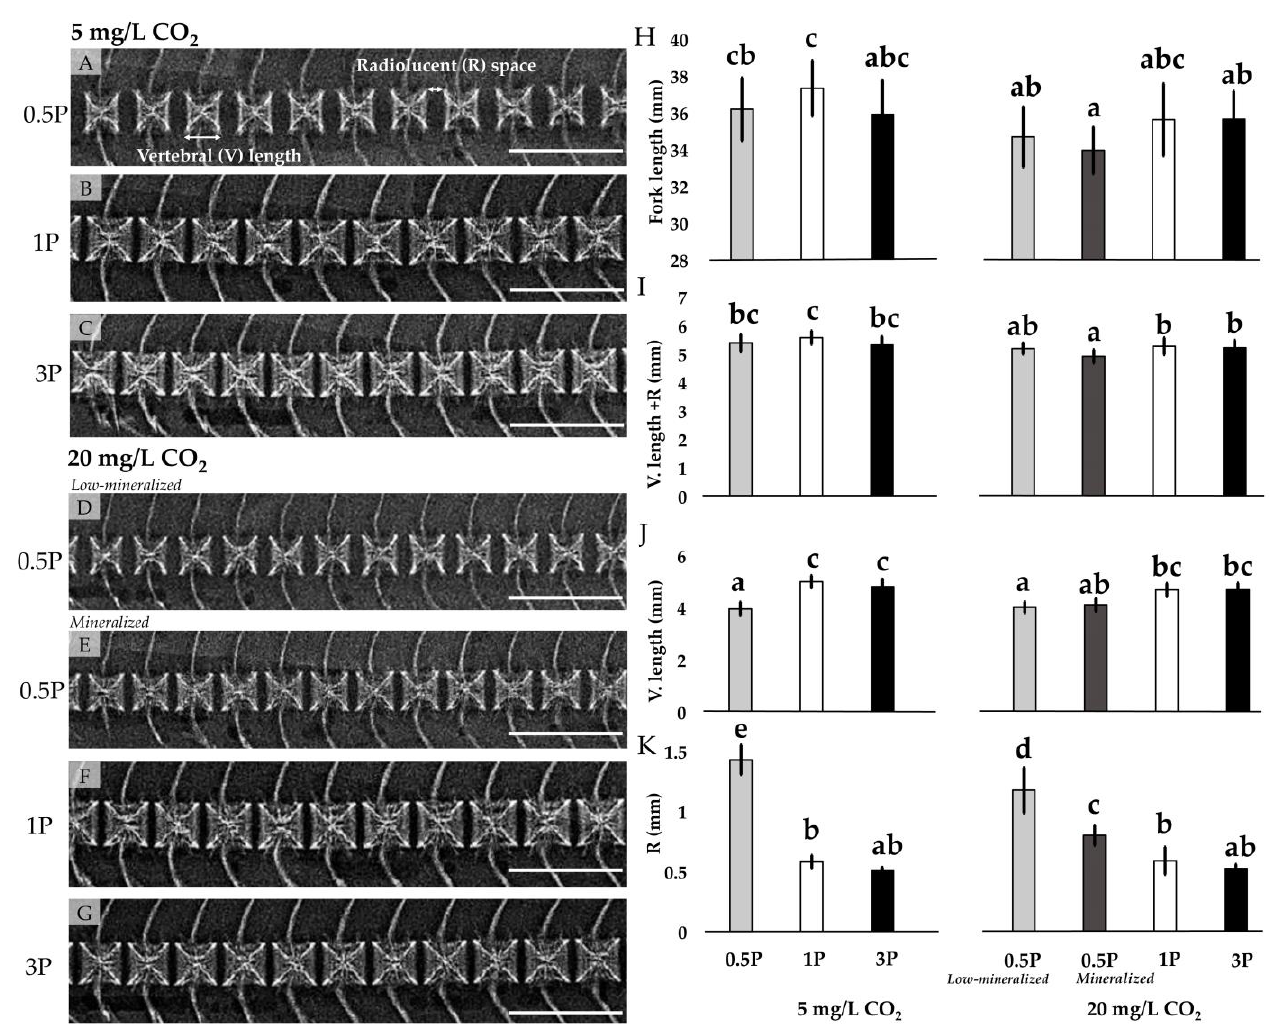
Figure 4. Radiography. X-ray images, scale bar = 1.5 cm, show representatives of vertebral centra of animals fed different levels of total phosphorus (P) 0.5P (6.3 g/kg), 1P (9.0 g/kg), and 3P (26.8 g/kg) and reared in conditions with no CO 2 injected (5 mg/L) or with injected CO 2 (20 mg/L) ( A – G ); Vertebrae were analyzed for the extent of vertebral (V) length and radiolucent (R) space ( A ); Vertebral bodies in 15 out of 30 animals fed 0.5P diet and reared in CO 2 20 mg/L were mineralized. Significant differences in measurements are denoted by a different letter. Fork length and V. length + R in mineralized 0.5P/20CO 2 animals were significantly reduced compared with 0.5P/5CO 2 animals ( H , I ); Vertebral length was significantly reduced in 0.5P/5CO 2 and 0.5P/20CO 2 low-mineralized animals ( J ); Radiolucent space was enlarged in 0.5P/5CO 2 animals. The low-mineralized phenotype was partially recovered at high CO 2 rearing conditions ( K